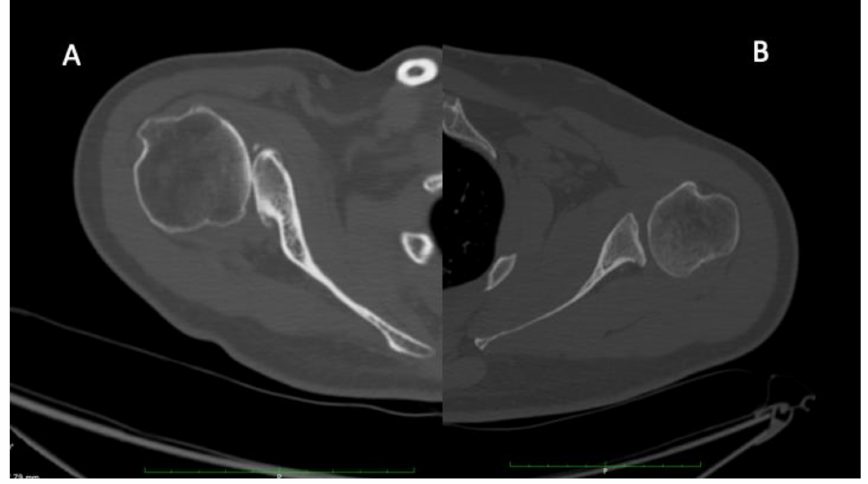
Figure 1. Illustration of C ( A ) and B ( B ) glenoids. C glenoid observed in severe neurological